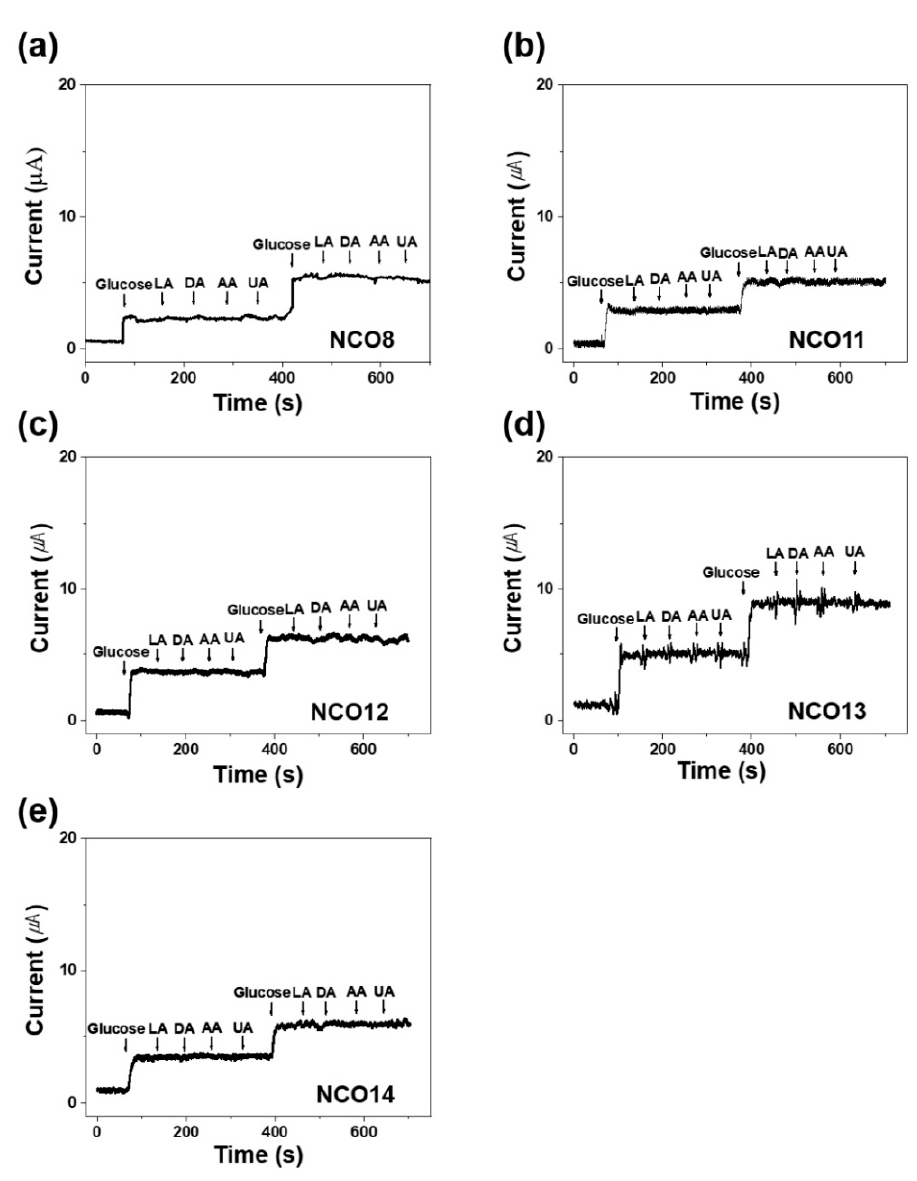
Figure 5. CA responses (CA) of ( a ) NCO8, ( b ) NCO11, ( c ) NCO12, ( d ) NCO13, and ( e ) NCO14 electrodes to addition of 1 mM glucose and 0.1 mM interfering species (LA, DA, AA, and UA) in a 0.1 M NaOH solution at 0.5 V.